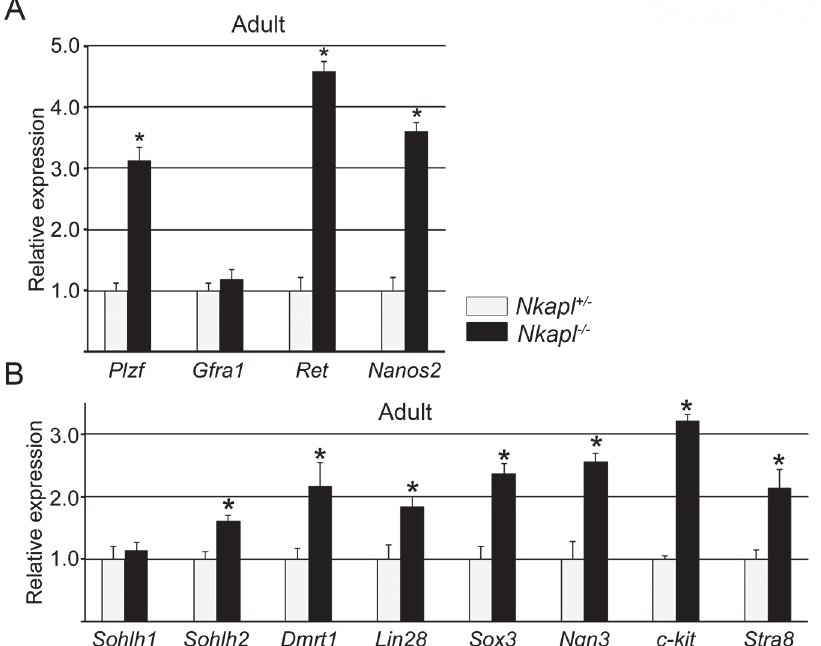
Fig 7. Nkapl deletion caused significant changes in spermatogonial stem cell (SSC) maintenance markers and increases in differentiation-related factors. (A) Transcriptional changes of SSC maintenance markers between testes of adult Nkapl +/- and Nkapl -/- mice by qRT-PCR. (B) Transcriptional changes of differentiation-related factors. Error bars indicate standard deviation from the means. * P <